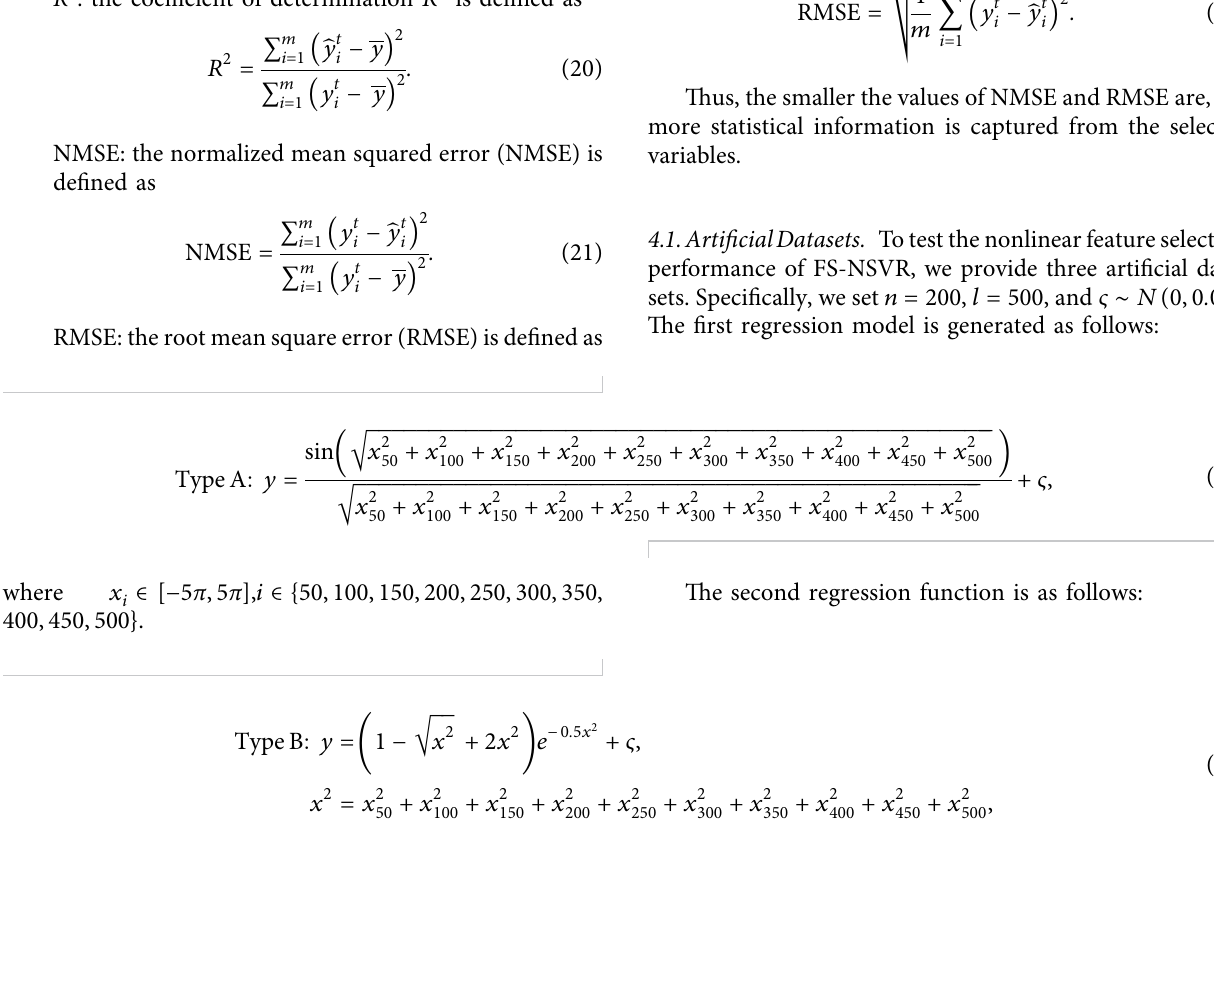
P : the proportion of simulation runs with nonzero 1 coefcients are selected R 2 : the coefcient of determination R 2 is defned